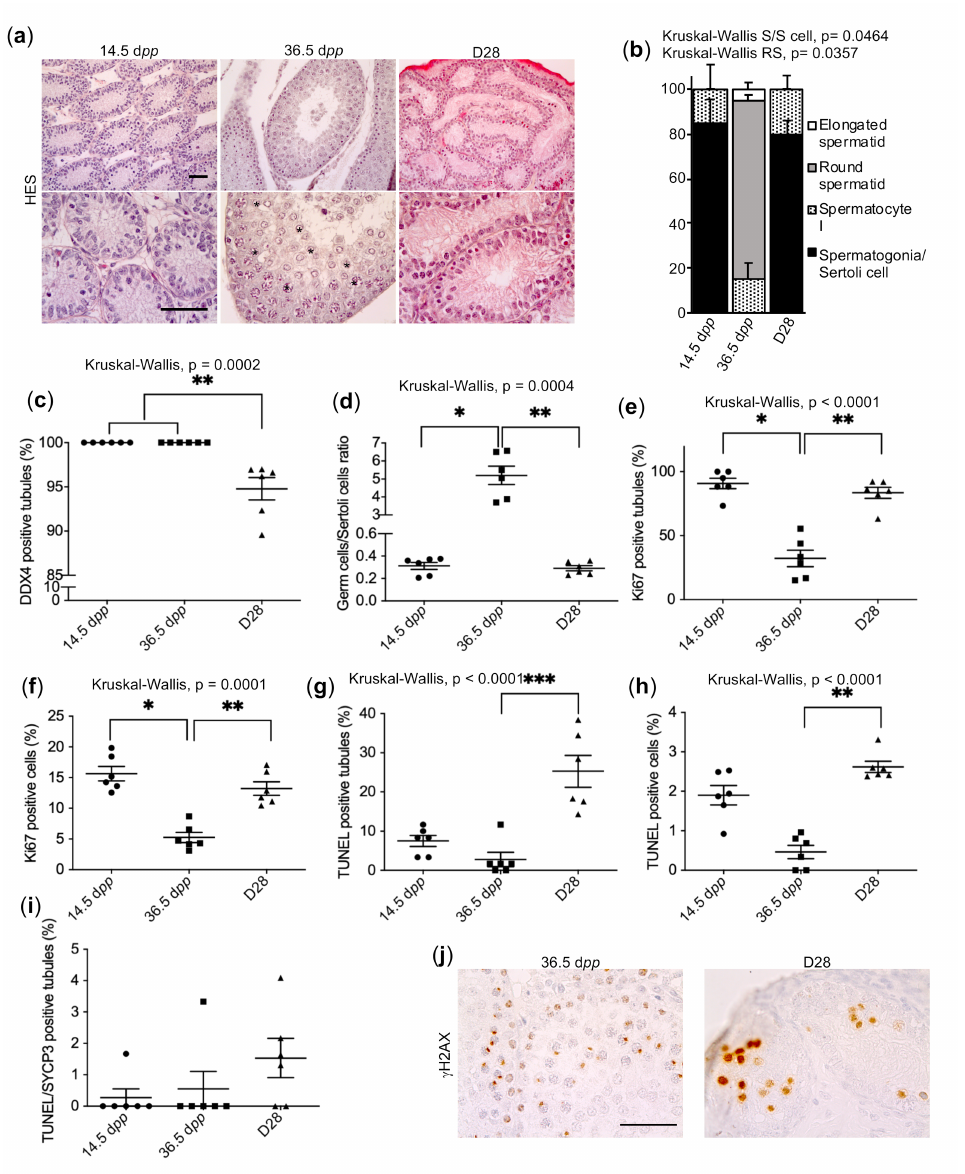
Figure 1. Histological and immunohistochemical evaluation of D28 in vitro cultured tissues sec- tions. ( a ) HES staining of paraffin-embedded testicular tissue sections. Scale bar: 50 µ m; Magni- fication: × 200 (upper panel) and × 500 (lower panel). Tissues cultured for 28 days (D28), tissues recovered from an age-matched in vivo control (36.5 dpp) and from an immature in vivo control (14.5 dpp) were analysed. Germ cells were observed in the adluminal compartment (*) only at 36.5 dpp. The most advanced stage of spermatogenesis ( b ) was evaluated ( n = 3). DDX4 immunos- taining was performed to determine the percentage of seminiferous tubules containing germ cells ( c ) and the intratubular germ cells/Sertoli cells ratio ( d ). ( e ) Percentage of Ki67-positive tubules and ( f ) Ki67-positive cells. ( g ) Percentage of TUNEL-positive tubules and ( h ) TUNEL-positive cells. ( i ) Percentage of SYCP3-positive cells (spermatocytes) presenting DNA fragmentation (TUNEL posi- tive). ( j ) Immunohistochemical localization of γ H2AX in paraffin-embedded testicular tissue sections from 36.5 dpp (left) and D28 cultured tissues (right). Indistinguishable XY bodies and a dispersed staining within the nuclei were observed in cultured tissues. Scale bar: 50 µ m; Magnification: × 500. Unless otherwise, n = 6. For statistical analyses, Kruskal–Wallis tests followed by Dunn’s post-test were applied. Data are expressed as mean ± s.e.m. * p value < 0.05; ** p value < 0.01; *** p value < 0.001. dpp, days post-partum; S/S cell, Spermatogonia/Sertoli cell; HES, Hemalun eosin saffron; RS, Round